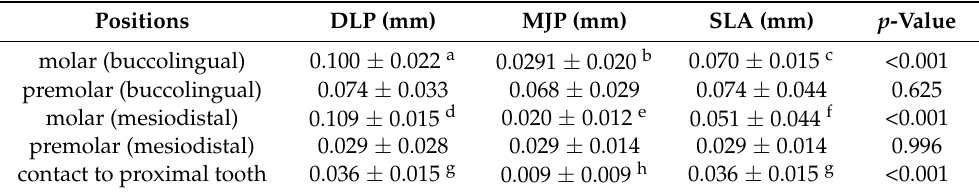
Table 4. The absolute values of deviations for 3D-printed models at margins and contact area. Positions DLP (mm) MJP (mm) molar (buccolingual) 0.100 ± 0.022 a premolar (buccolingual) molar (mesiodistal) contact to proximal tooth 0.036 ± 0.015 g